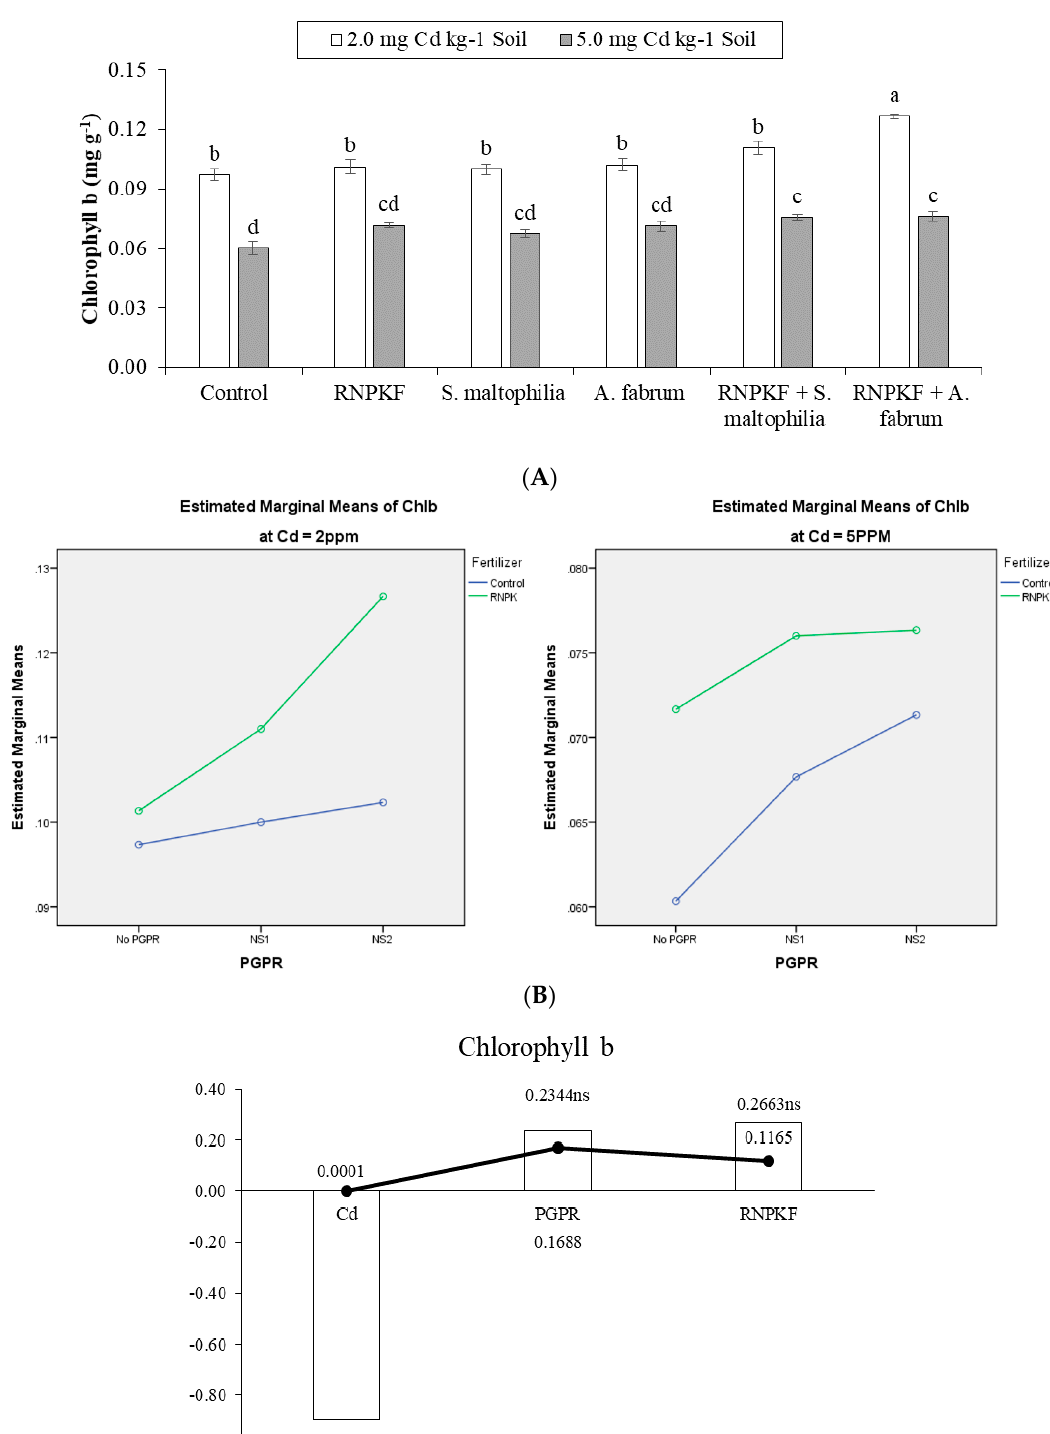
Figure 5. Effect of rhizobacteria with and without recommended NPK fertilizer on chlorophyll b (Chlb) of bitter gourd under Cd ( A ). Interaction graph of PGPR (NS1 = S. maltophilia , NS2 = A. Figure 1). ( B ). Pearson correlation of Chlb with different levels of Cd, ACCD PGPR, and recommended NPK fertilizer where the y -axis represents the values of correlation (bars in the graph) and x -axis probability (lines in the graph) ( C ). * = p ≤ 0.05; ns = p > 0.05 non-significant.